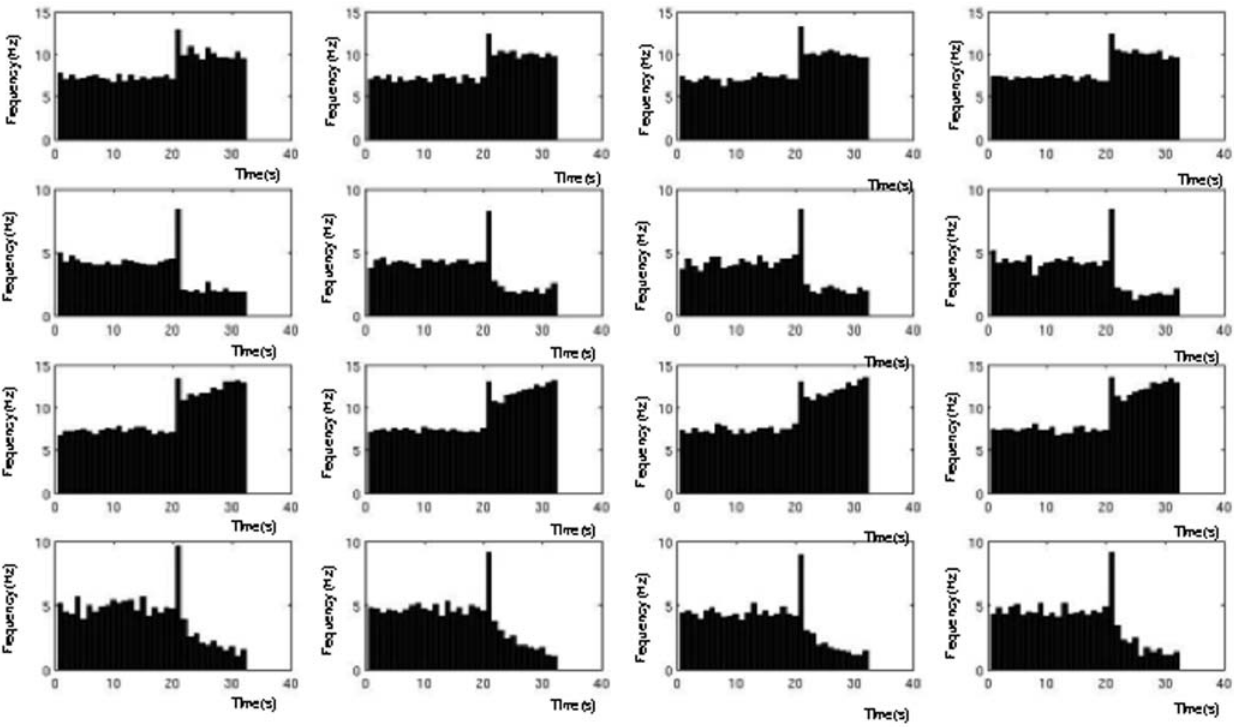
Figure 11. Average PSTH histograms of 16 units randomly chosen from the 2000 unit 4-population spiking model. Note that the entire range of pattern types continue to be exhibited (excitatory and inhibitory stable, decaying, and ramping delays and nonresponsive) with firing statistics similar to real neurons.